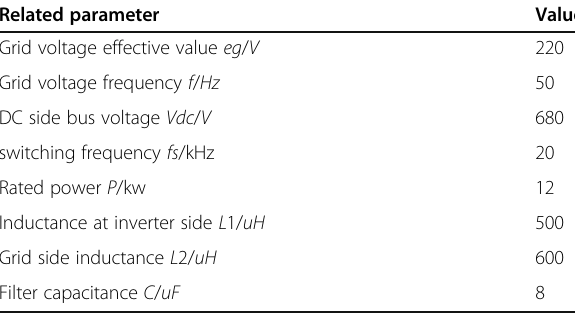
Table 1 Inverter default